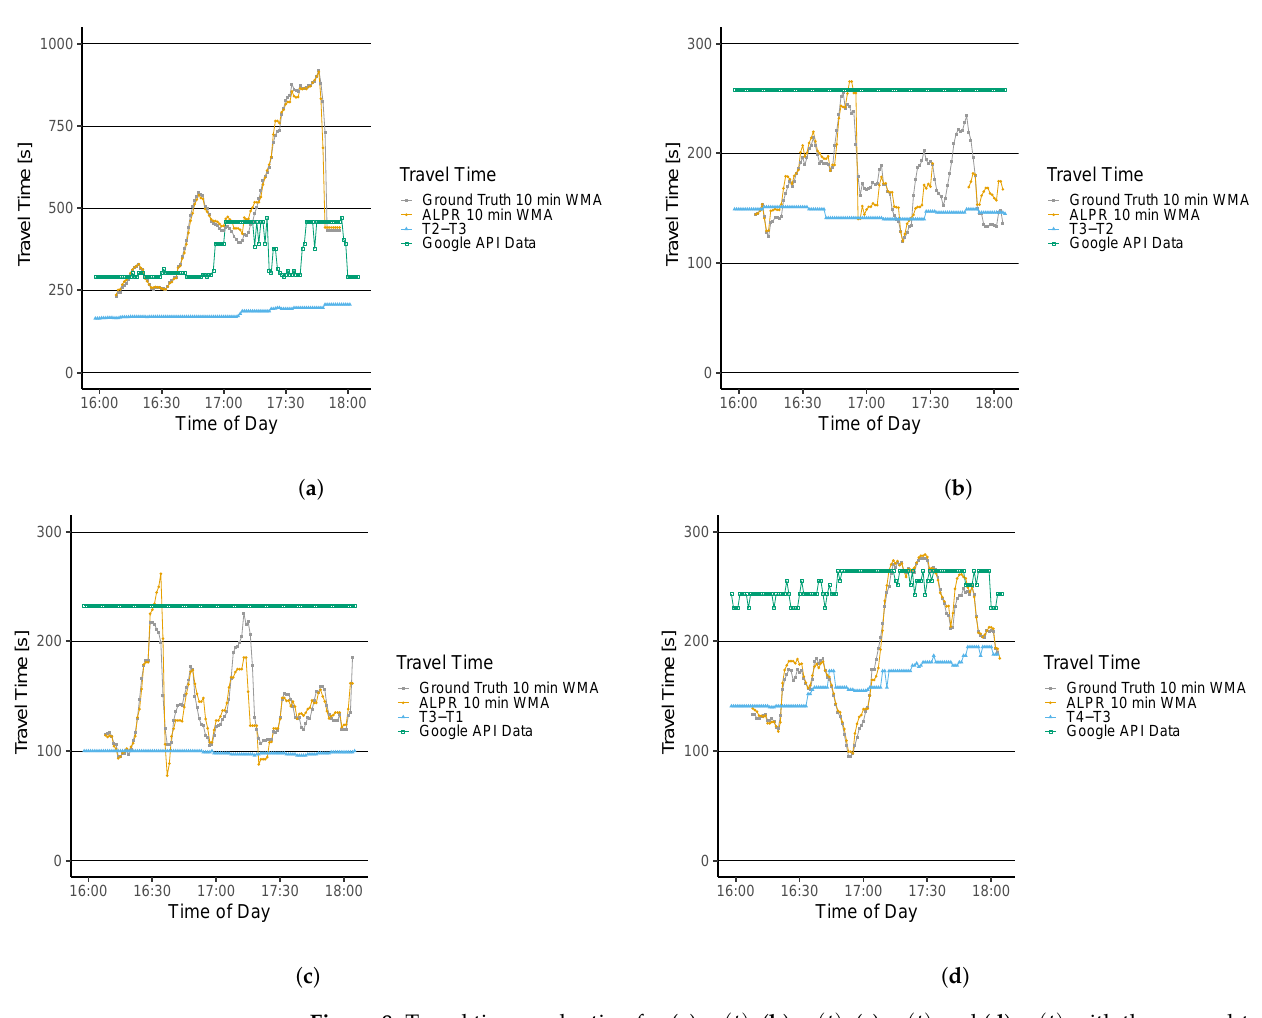
Figure 8. Travel time evaluation for ( a ) τ 1 ( t ) , ( b ) τ 3 ( t ) , ( c ) τ 4 ( t ) and ( d ) τ 5 ( t ) with the ground-truth measurement, the ALPR, the set of thermal cameras, and the Google Distance Matrix API data set. The performance metrics are compiled in Table 2. One can note that the quantity τ 1 ( t ) increases over time, peaks around 17:45, and decreases again afterward. Results computed from the ALPR detections (orange time series) replicate this trend with small deviations. The time series correlate with ρ = 0.99 and an MAPE = 3.14%. Contrary results are shown by the set of thermal cameras T2 and T3 that are utilized for travel time derivation of τ 1 ( t ) . The time series only shows small variations and does not capture the trend of the ground-truth data ( ρ = 0.71, MAPE = 58.07%). Potential reasons